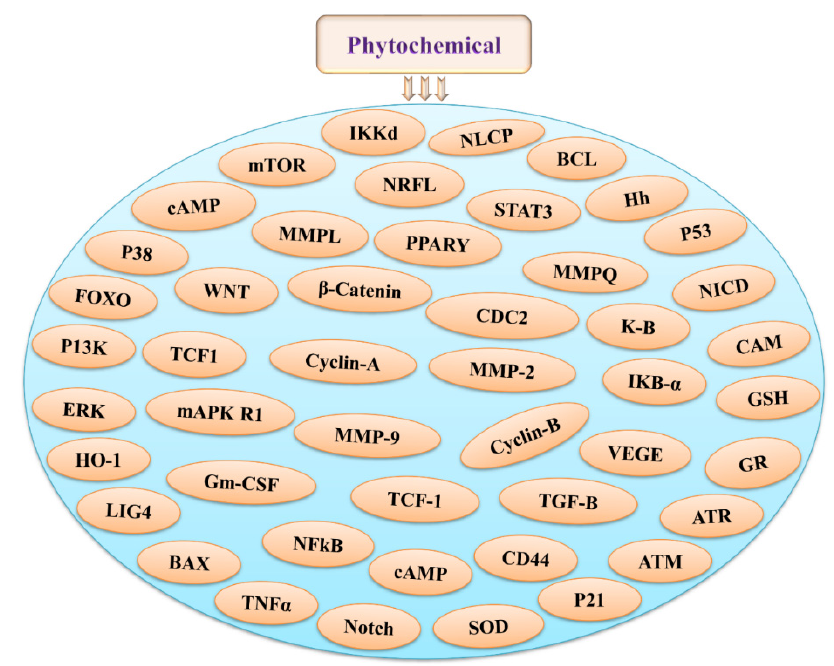
Figure 2. Different intermediates as a potential targets for phytochemicals during radiation-induced